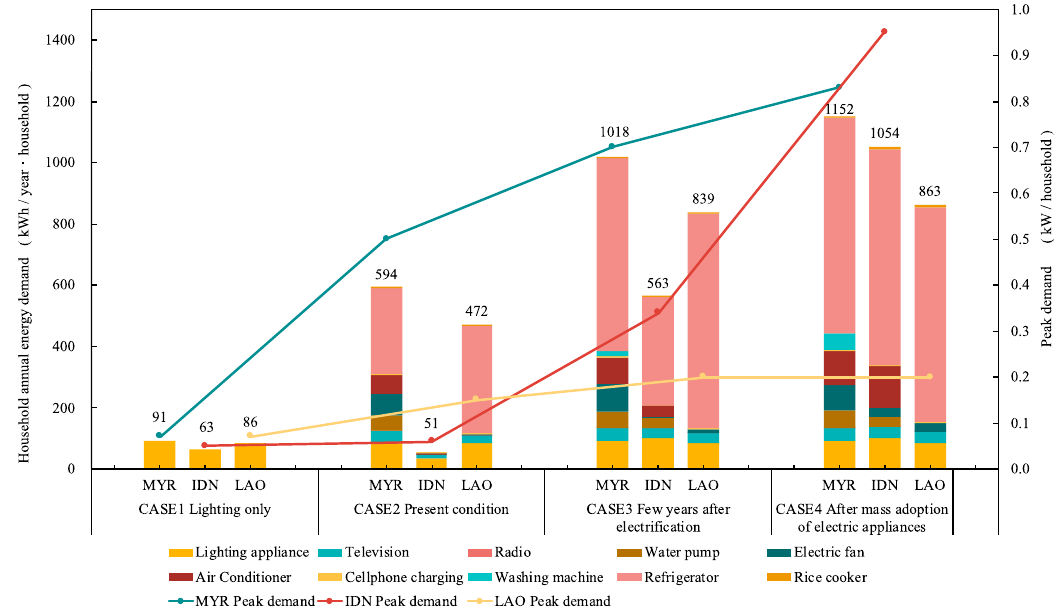
Figure 9. Projection of household annual energy demand and peak demand in each case scenarios and case study villages. MYR: Myanmar; IDN: Indonesia; LAO: Laos.